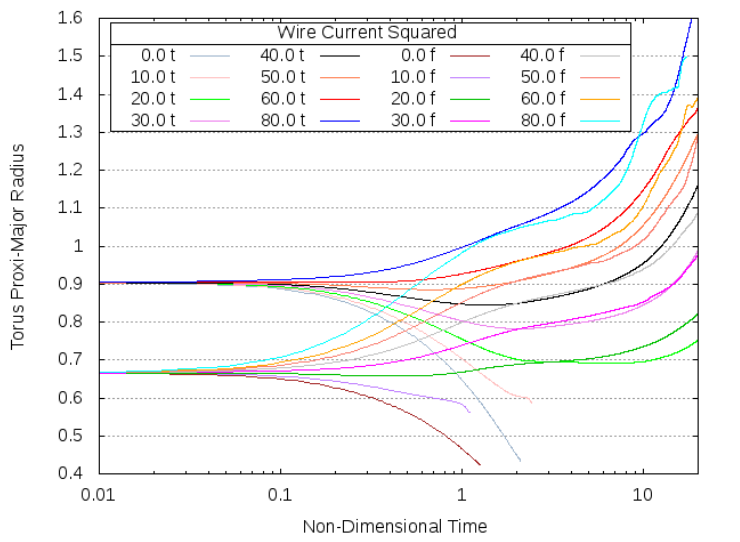
Figure 3. Plots of the proxi-major torus radii ˜ R over non-dimensional time t from two different initial states “f” and “t”, with respectively ˜ R ≡ R = 0.66 and ≈ 0.9 (scaled out from 0.84 to give same torus volume—see text) for a selection of different wire currents, i 2